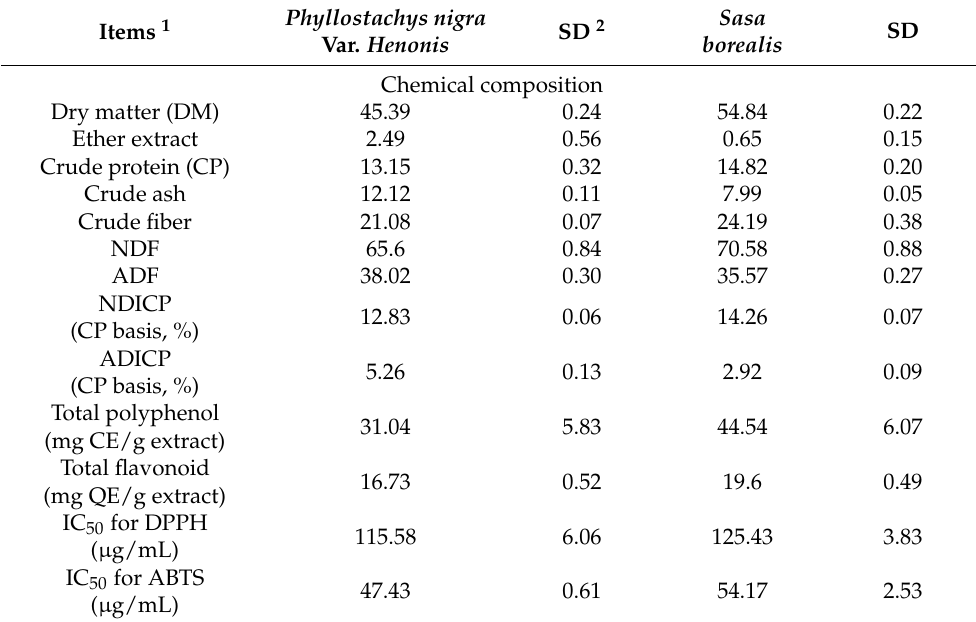
Table 3. Chemical composition and antioxidant activity of bamboo leaves (DM basis, %).